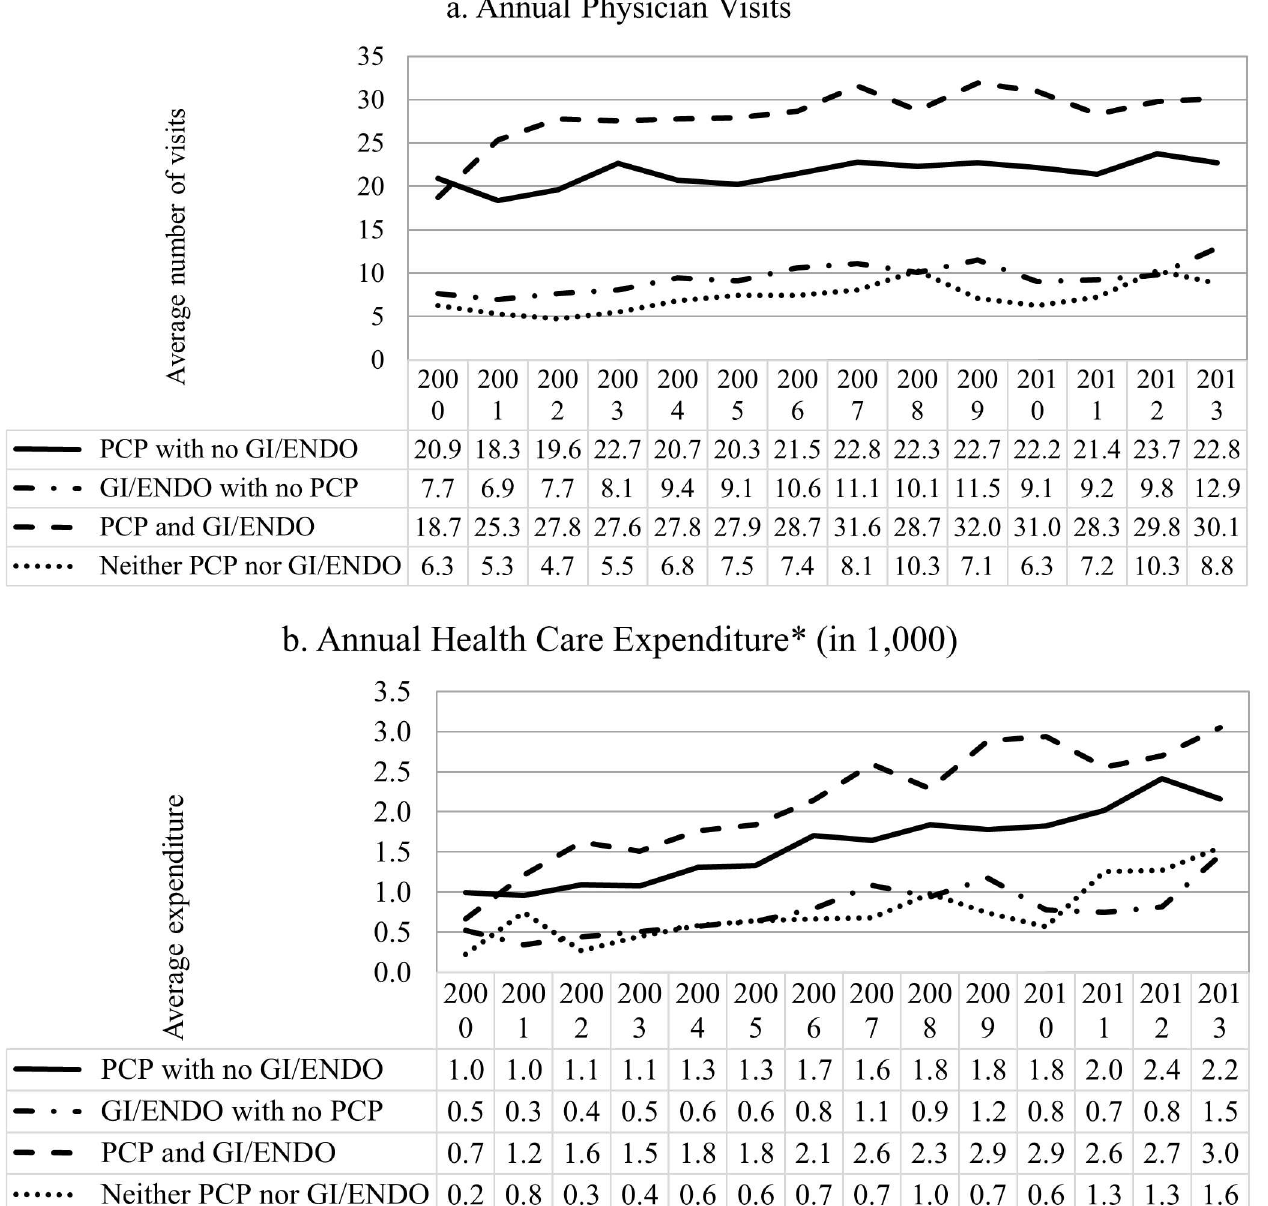
Fig 3. Average number of annual health care utilization among dually diagnosed patients, by physician mix category.